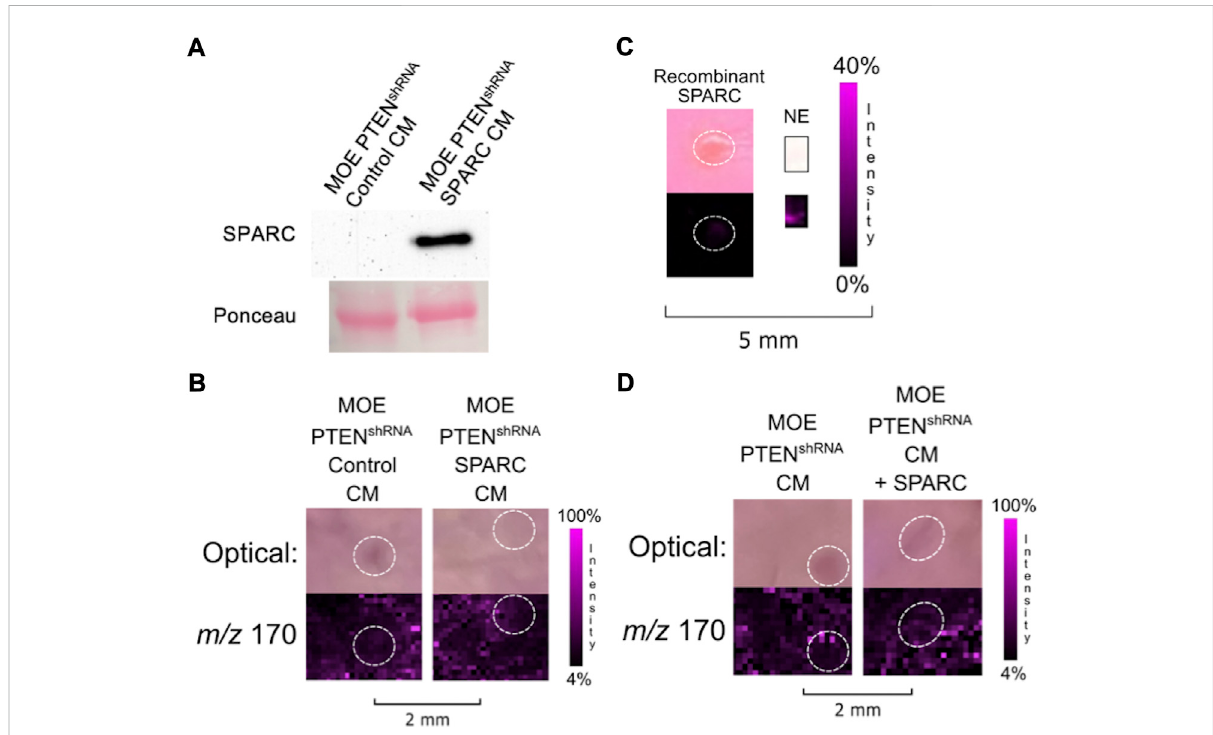
FIGURE 5 (A) Transfection of SPARC in MOE PTEN shRNA results in overexpression of SPARC protein compared to transfection with a control plasmid. (B) Conditioned media from MOE PTEN shRNA SPARC co-cultured with ovarian explant does not increase NE signal from ovary. (C) Treatment of ovary with recombinant SPARC (10 μ g/150 μ L) does not increase NE signal from ovary. (D) Ovarian explant treated with conditioned media from MOE PTEN shRNA combined with recombinant SPARC (50 ng/150 μ L) does not increase NE signal from ovary. Ovaries are circled with a white dotted line. IMS Method B was used for this fi gure. CM stands for conditioned